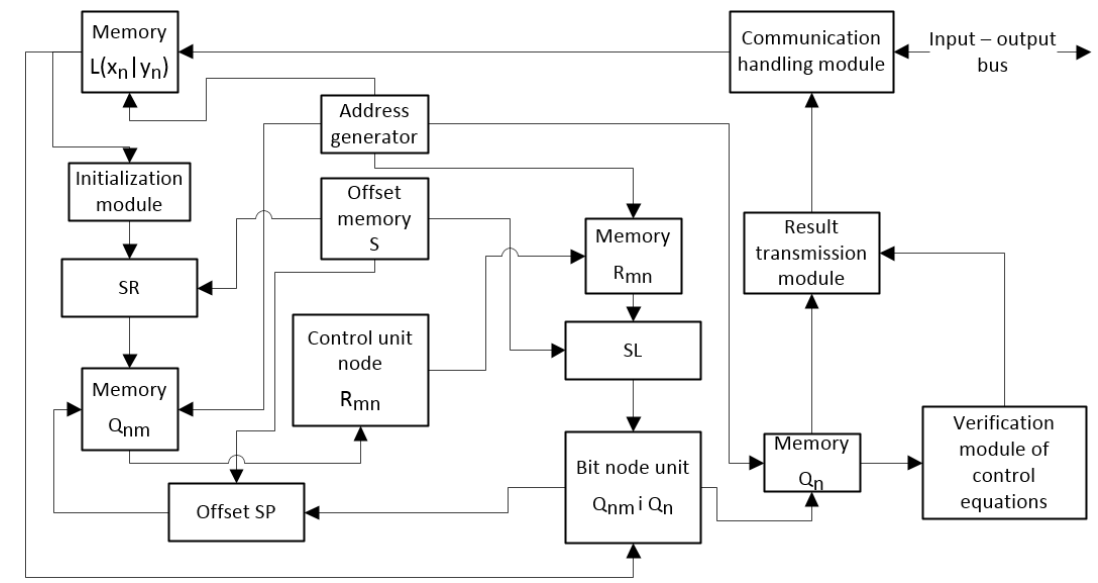
Figure 3. Block diagram of the QC-LDPC irregular code